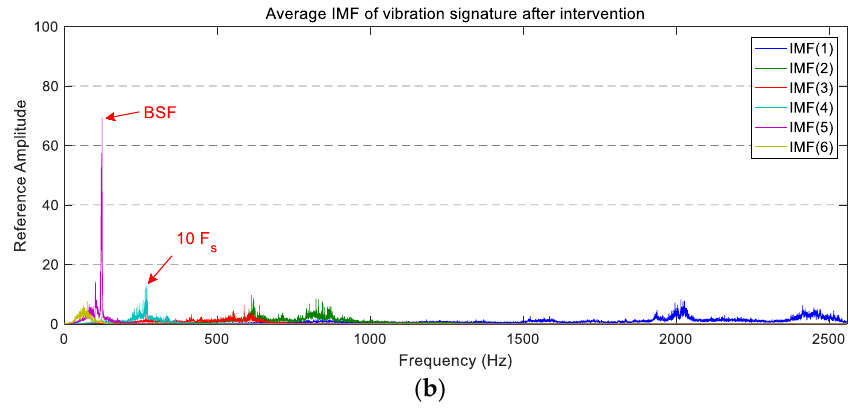
Figure 10. The average PSD of the IMFs corresponding to the longitudinal vibration signals: ( a ) before maintenance; ( b ) after maintenance.